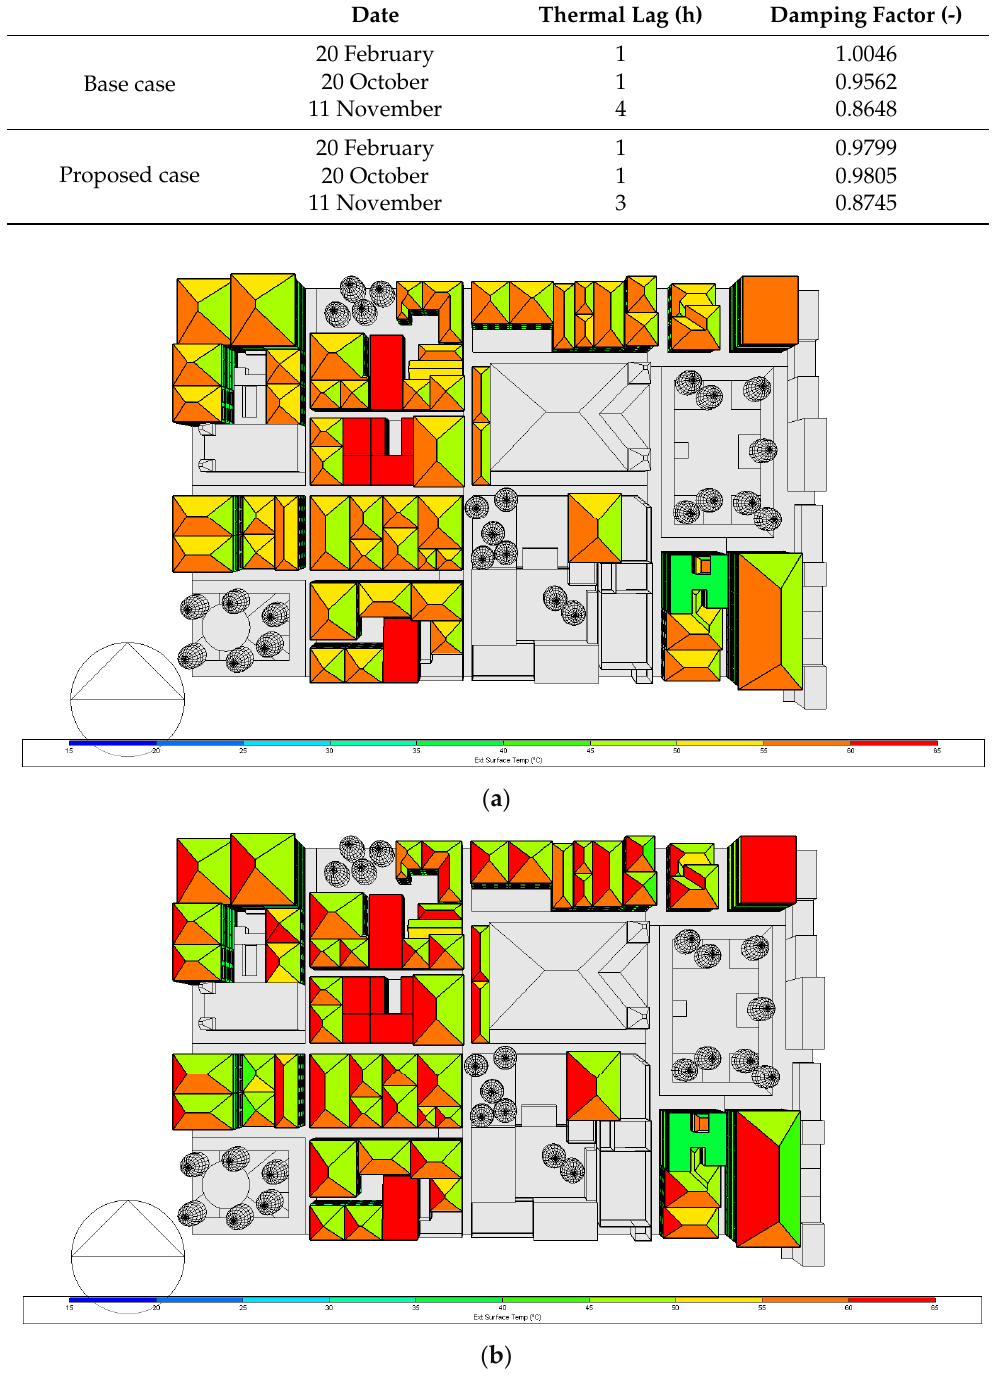
Figure 11. External surface temperature for the base case: ( a ) 17 March and ( b ) 20 October at 15 h. Own